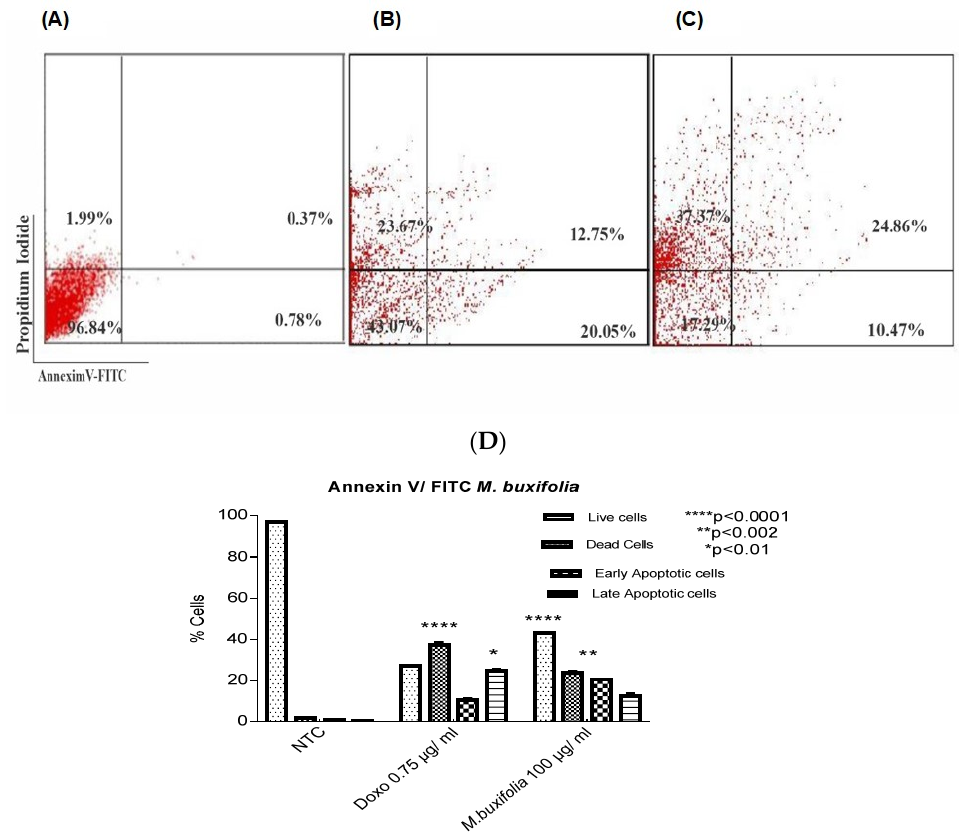
Figure 4. Representative flow cytometric dot plots representing individuals showing values close to mean values in all three groups. Apoptosis assay for MCF-7 cells isolated from NTC (non- treated) ( A ), Doxo = Doxorubicin-treated cells at 0.75 µ g/mL ( B ) and MMBL-treated at 300 µ g/mL ( C ). Four quadrants are shown i.e., lower left (LL) representing viable cells, upper left (UL) repre- senting dead cells, lower right (LR) representing early apoptotic cells and upper right (UR) repre- senting late apoptotic cells. ( D ). Graph showing percentage population of different cell types in NTC = non-treated cells, Doxorubicin-treated group, and MMBL-treated group. A highly significant ( p < 0.0001) difference was observed between live and dead cells in non-treated and treated group. The results showed that the MMBL-treated cells significantly increased apoptotic cells populations compared to untreated control cells. Significant data points are represented with asterisk